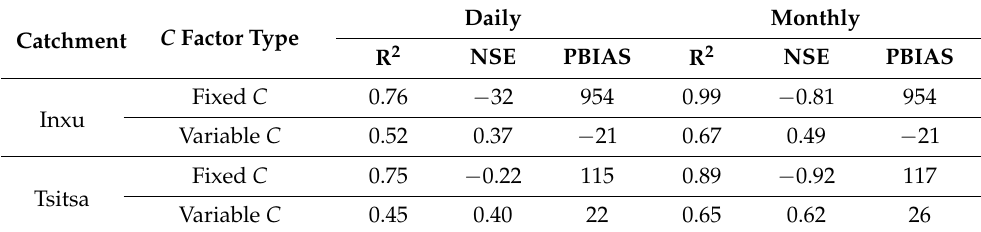
Table 5. Summary statistics comparing observed data sediment yield (SY) output attained using a fixed or variable C factor at daily and monthly